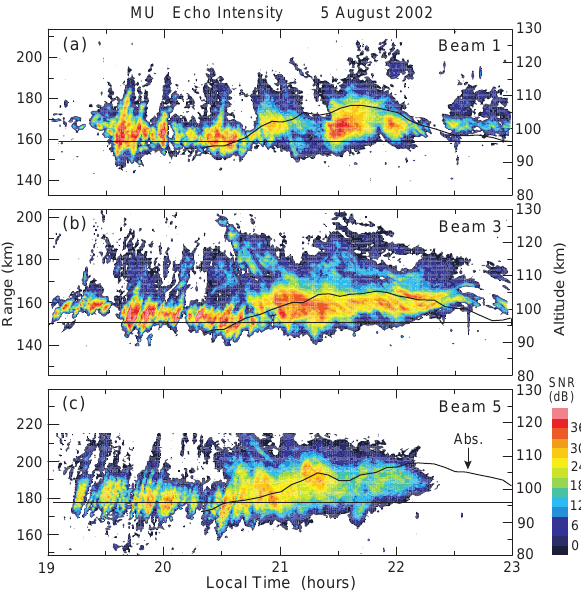
Fig. 5. Range-time-intensity (SNR) plots of MU radar echoes on beams 1, 3 and 5. The right ordinate represents altitudes calculated using slant ranges and zenith angle of each radar beam. Temporal variations of absolute intensity ( I 558 ; solid curve) at around 96km altitude, shown in Fig. 4a, are also